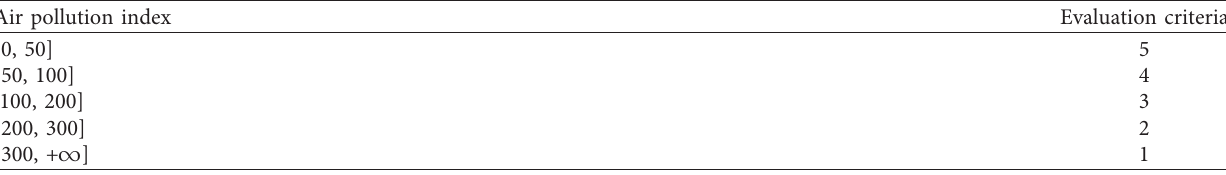
Table 5: Numerical table of the air pollution